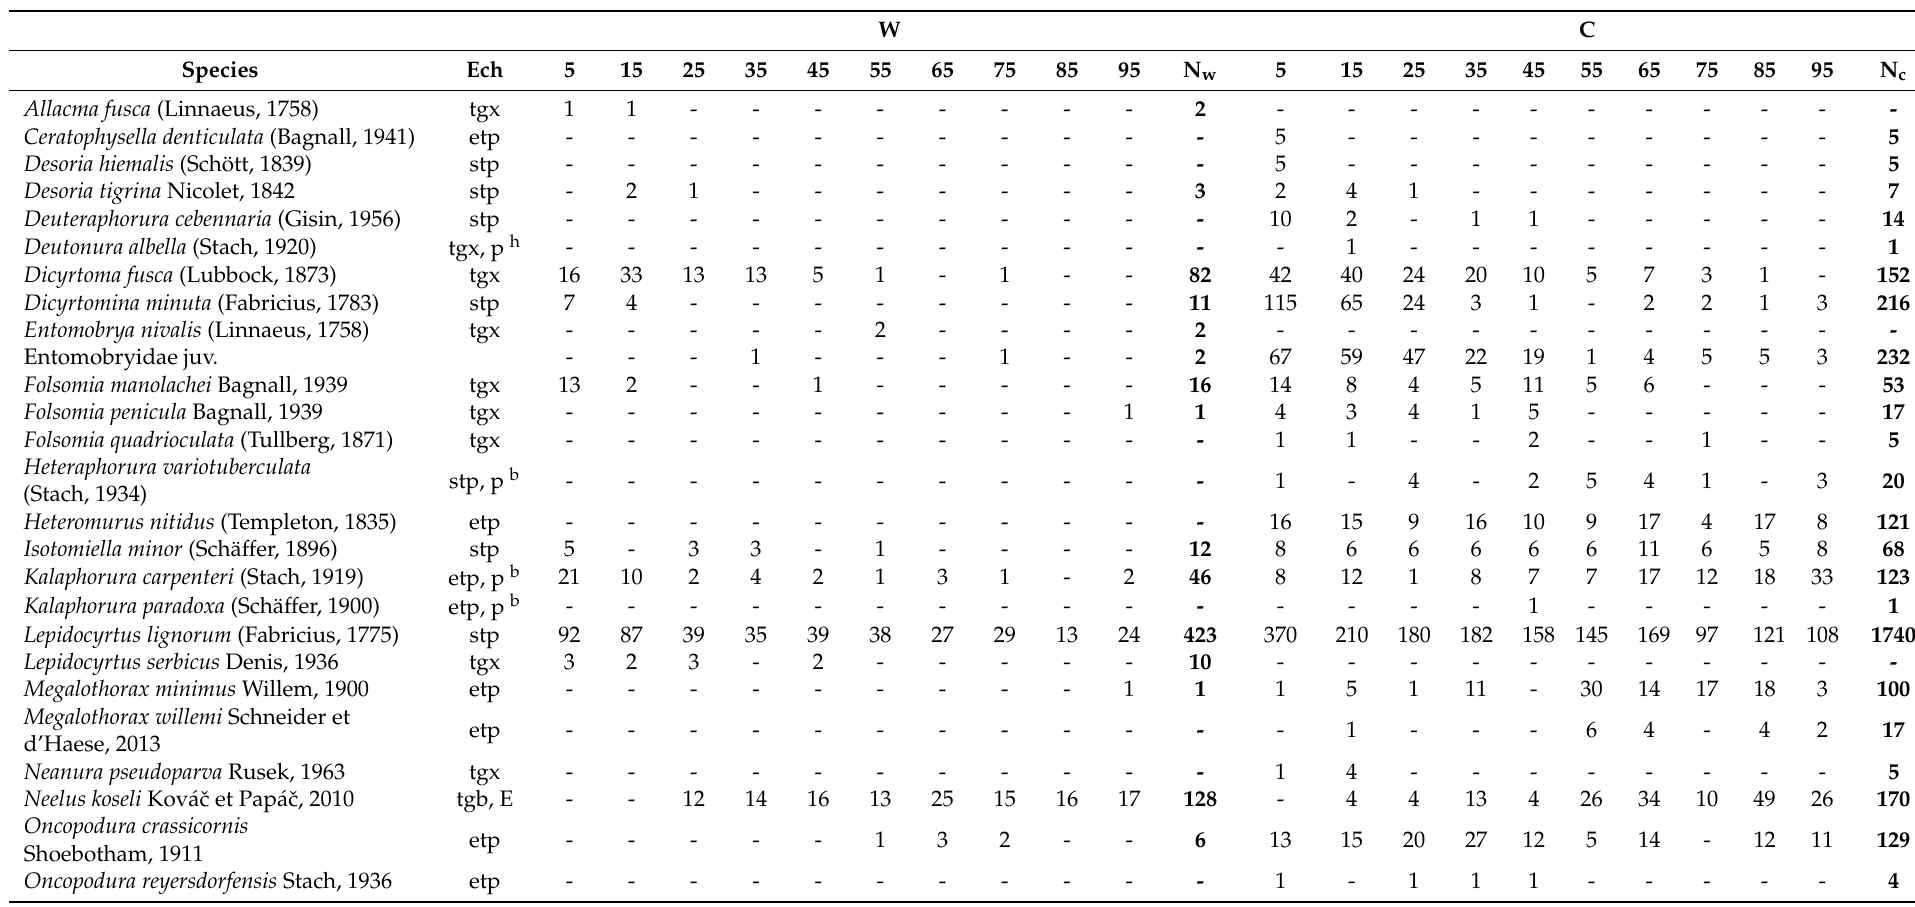
Table A2. Ecological characteristics of Collembola and their abundances in a vertical profile of 5 − 95 cm at the upper site of the scree slope (site SB) in warm and cold